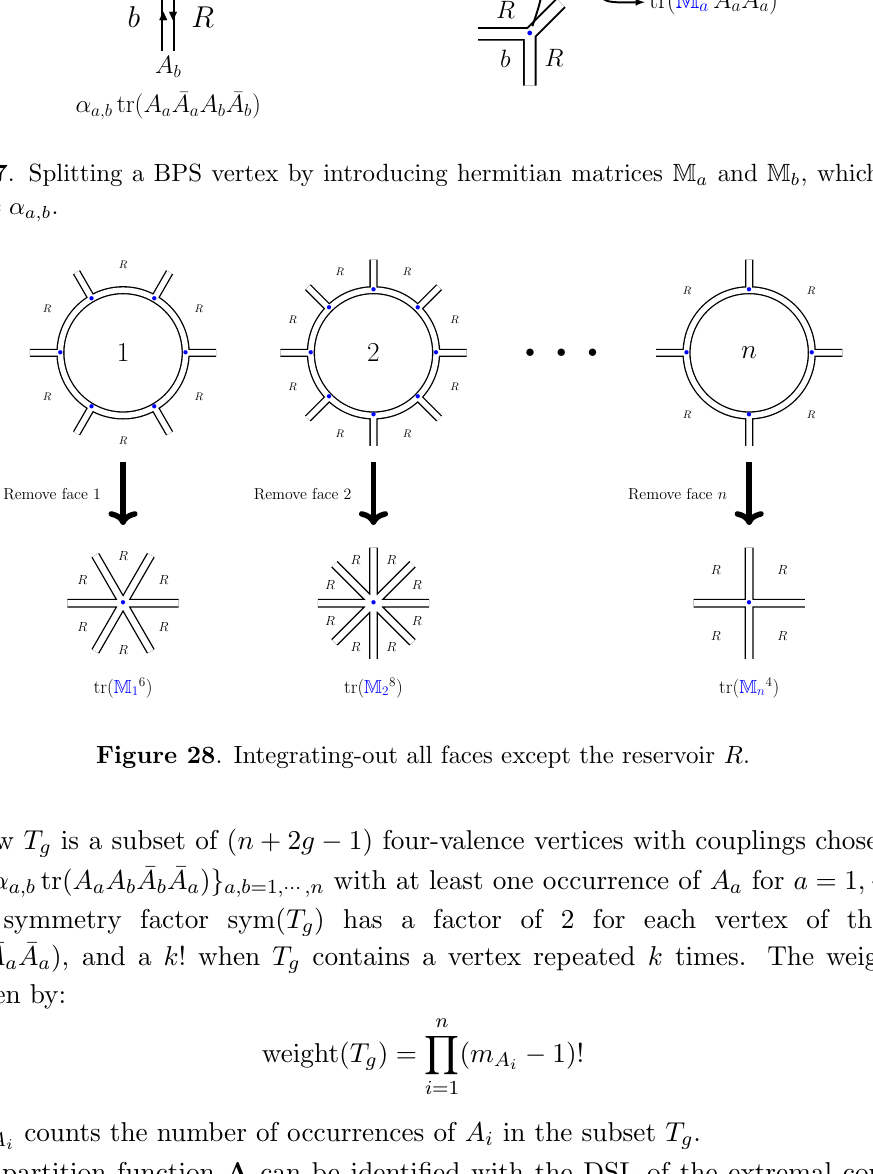
a and M b , which satisfy